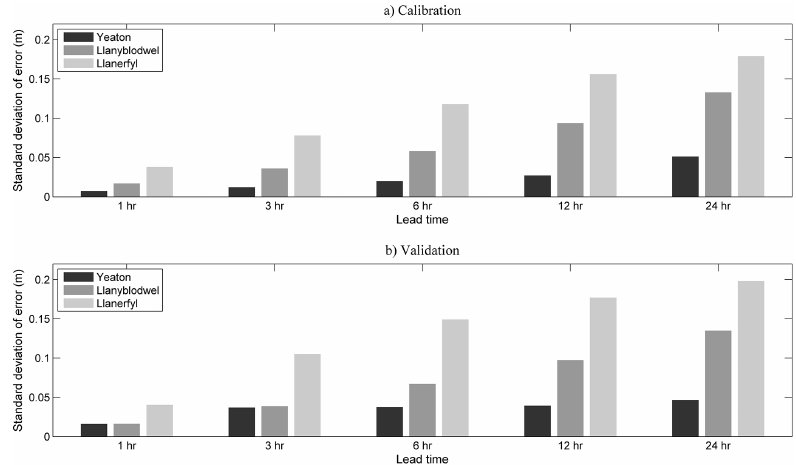
Figure 8. Standard deviation of model error during calibration and validation (Upper Severn catchments).